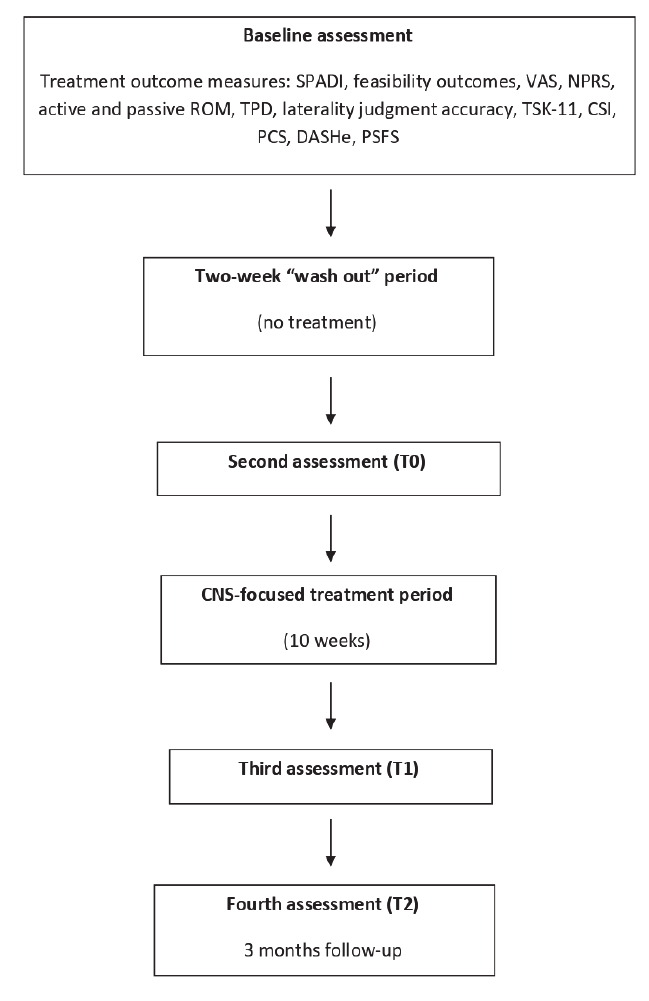
Figure 1. Assessment and treatment flowchart diagram.